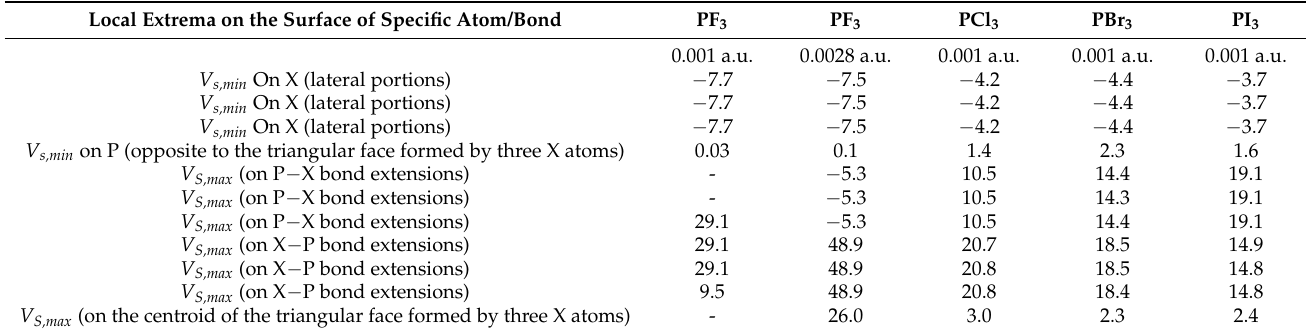
Table 1. The 0.001 a.u. isodensity envelope mapped potential on the electrostatic surface of PX 3 (X = F, Cl, Br, I) molecules, obtained using MP2(full)/def2-TZVPD a